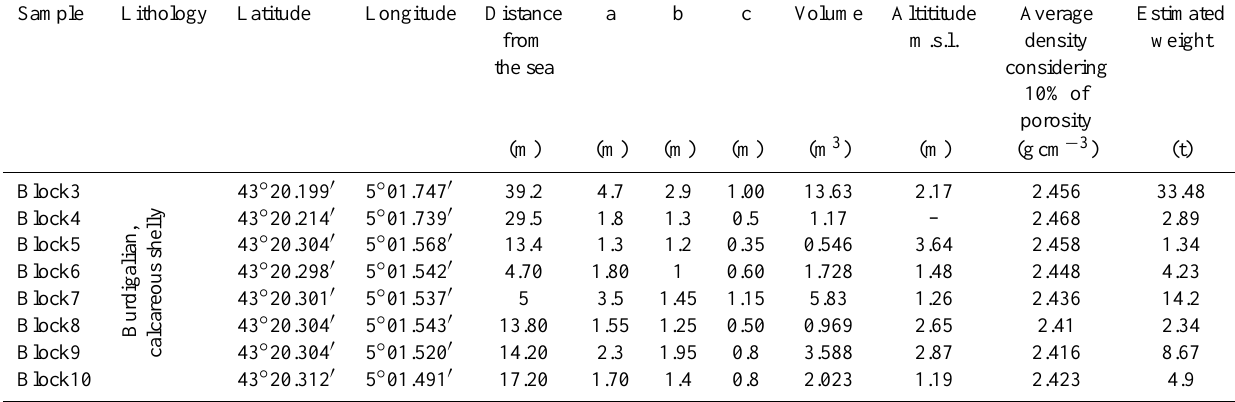
Table 1. Size, position and geological characteristics of boulders surveyed on the coast of the Gulf of Fos (a: long axis; b: width; c: thickness).